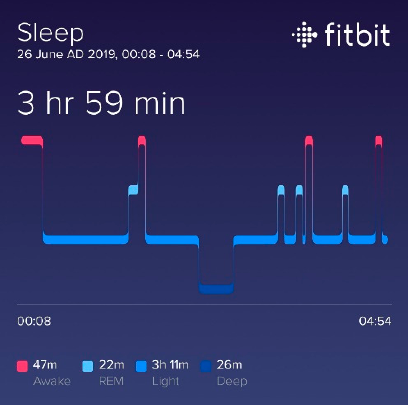
Figure A5. Taipei, Taiwan.